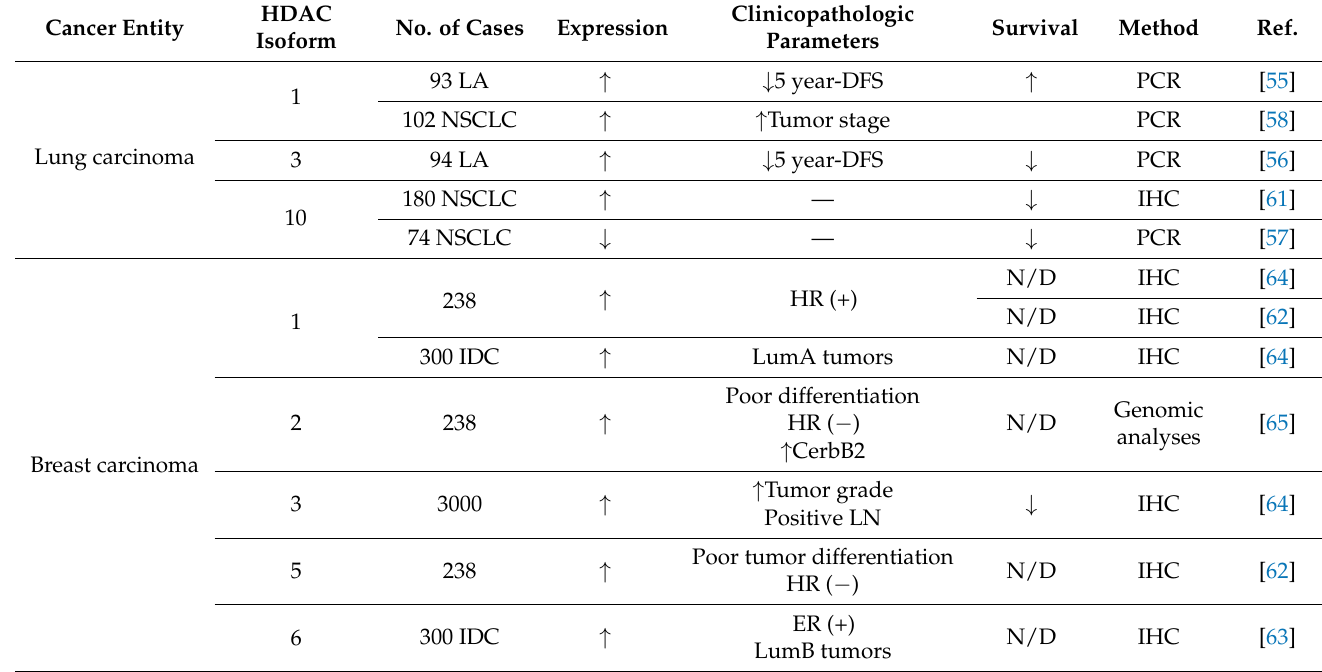
Table 4. Association of different HDAC isoforms expression in lung and breast tumors and their correlation with clinico- pathological parameters and patients’ survival. HDAC Cancer Entity No. of Cases Expression Isoform